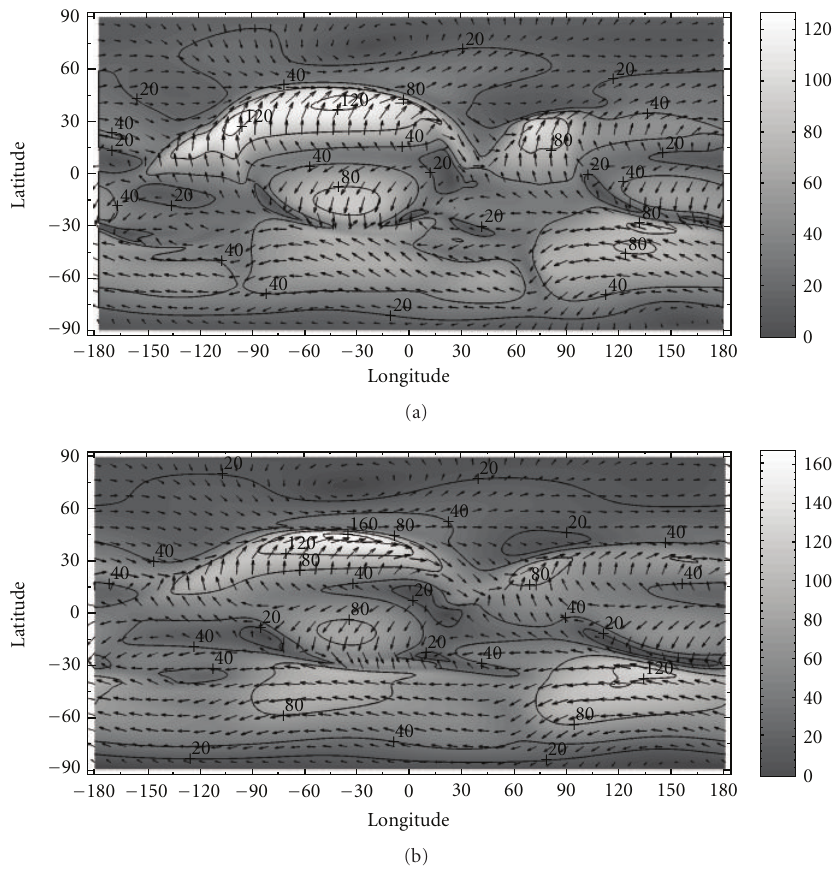
Figure 5: The same as in Figure 3 but at the altitude of